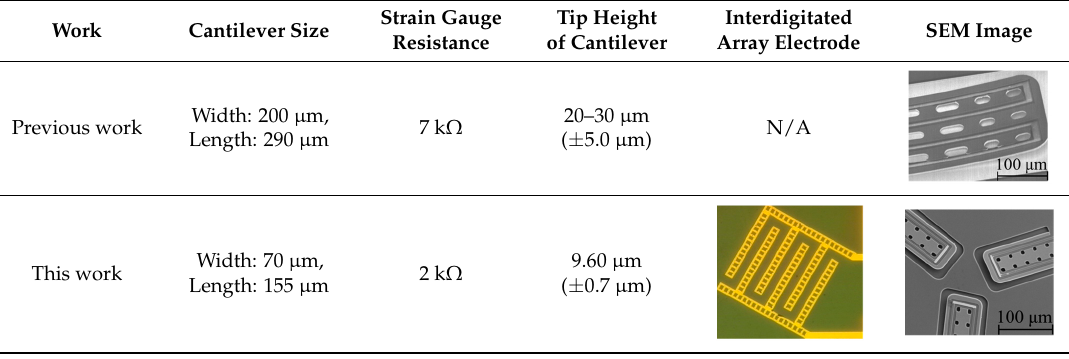
Table 1. Comparison of the structures of the previous sensor and newly fabricated sensor.